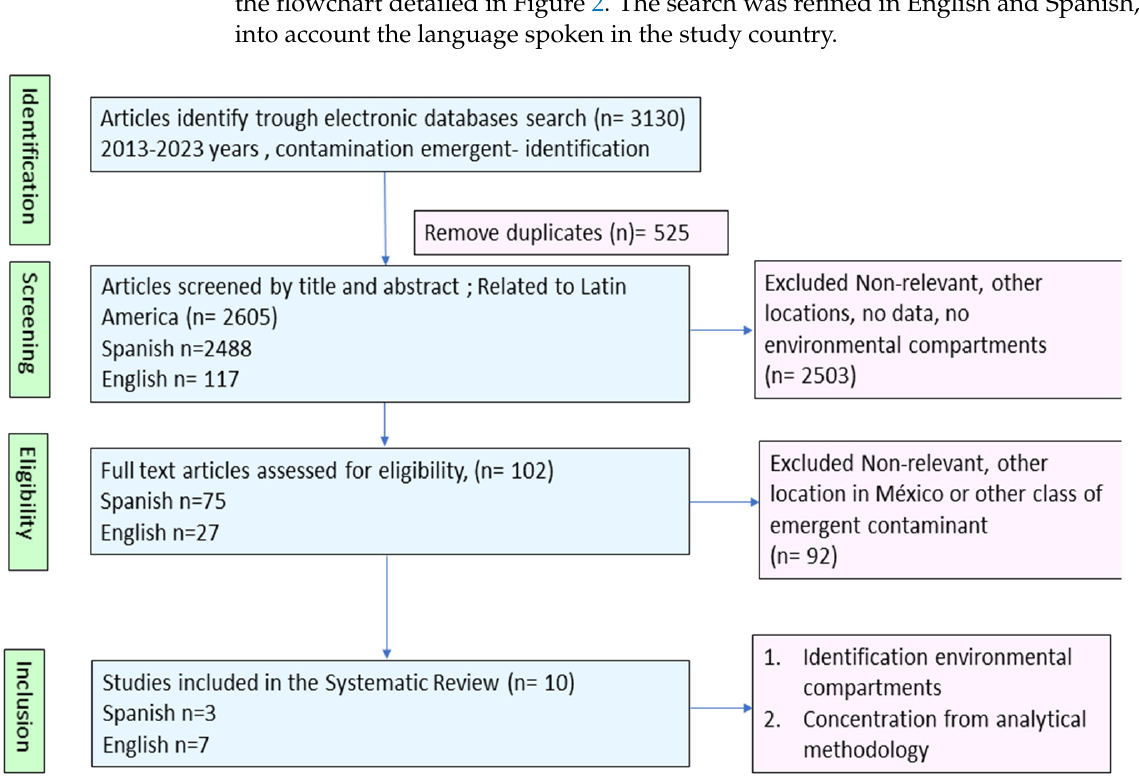
Figure 2. Disposal techniques according to gender.